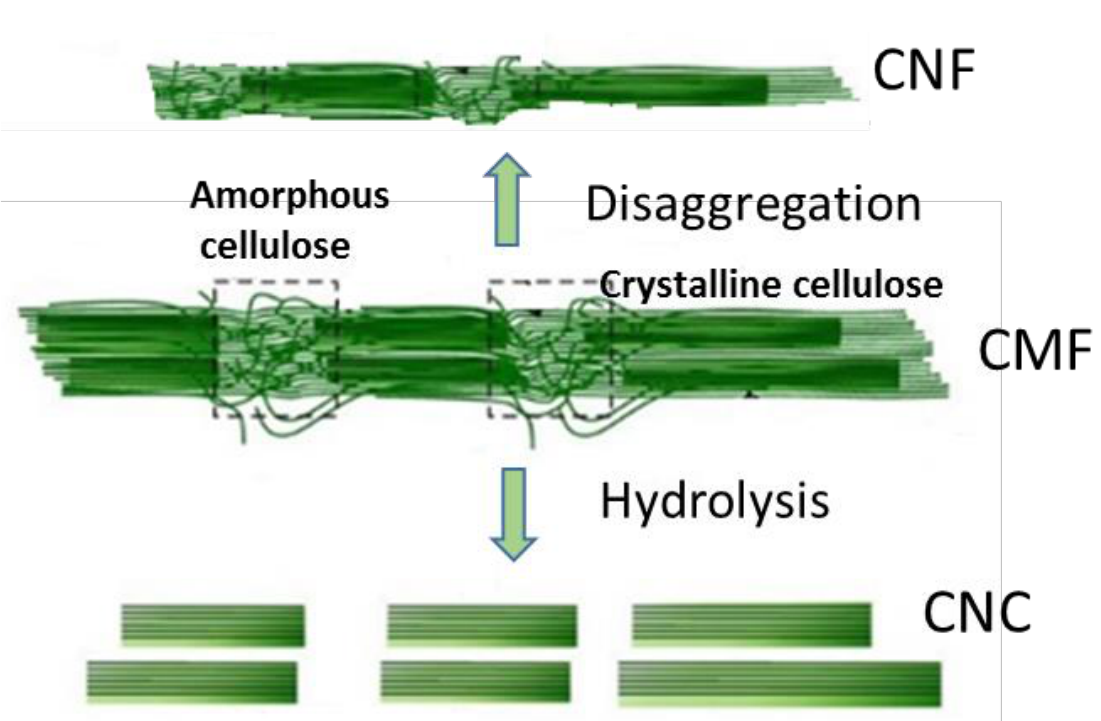
Figure 2. Schematic representation of cellulose nanofibrils (CNFs) production by disaggregation of cellulose microfibrils (CMFs) in the cell wall and the production of cellulose nanocrystals (CNCs) by the hydrolytic degradation of the amorphous part of CMF.